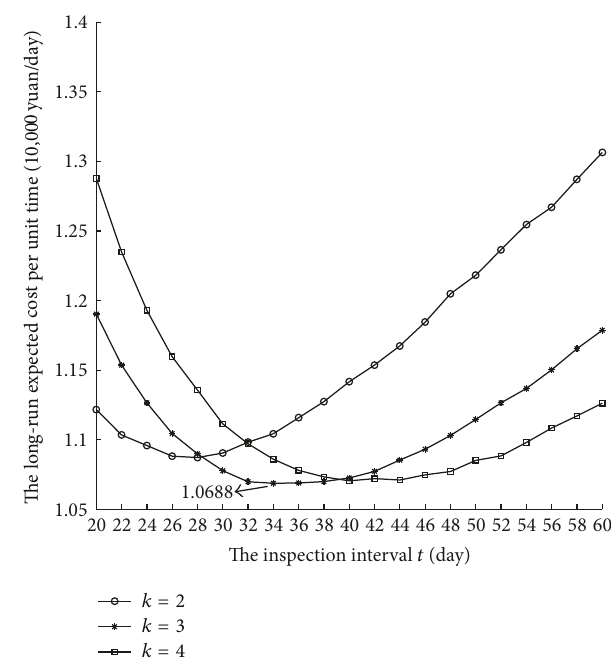
Figure 16: Long-run expected cost per unit time of model 𝐼𝐼